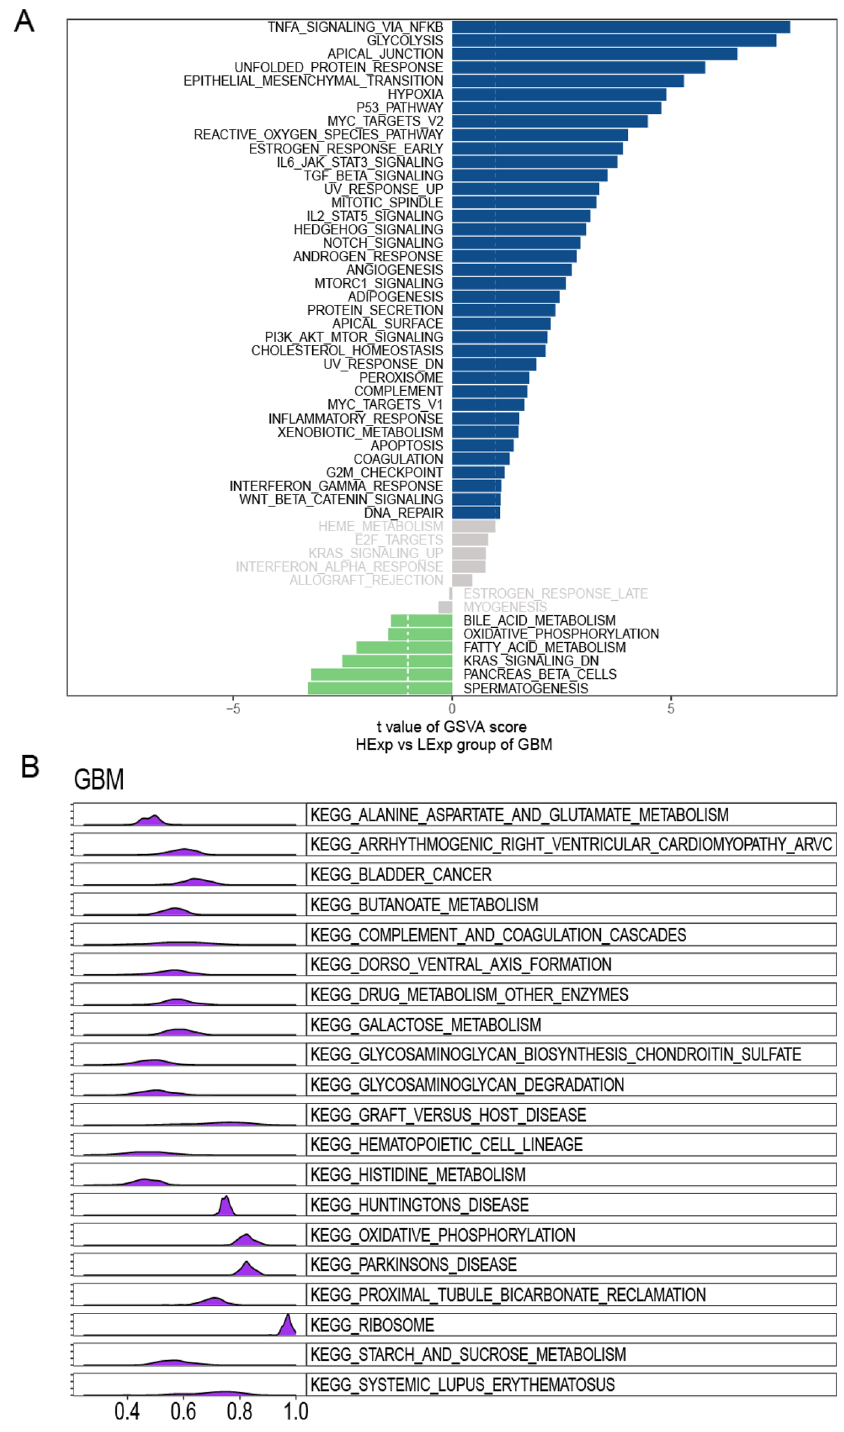
Figure 9. Function and pathway enrichment analysis of glioma. ( A ) Correlation analysis results of GSVA and SLC35C1 in glioma. ( B ) KEGG results of SLC35C1 GSEA in